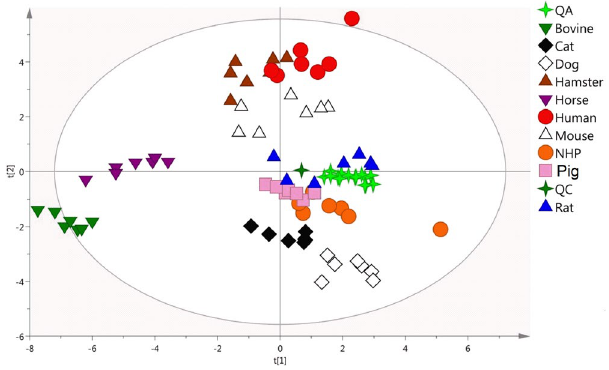
Figure 3. Comparison of targeted plasma lipid fingerprints of studied species. Principal component analysis (PCA) model based on 106 identified lipids from the lipid fingerprints of human and non-human plasma samples (n = 10 × 6). R2X = 0.744; Q2 = 0.577. PC contributions: PC1 = 0.242, PC2 = 0.153.